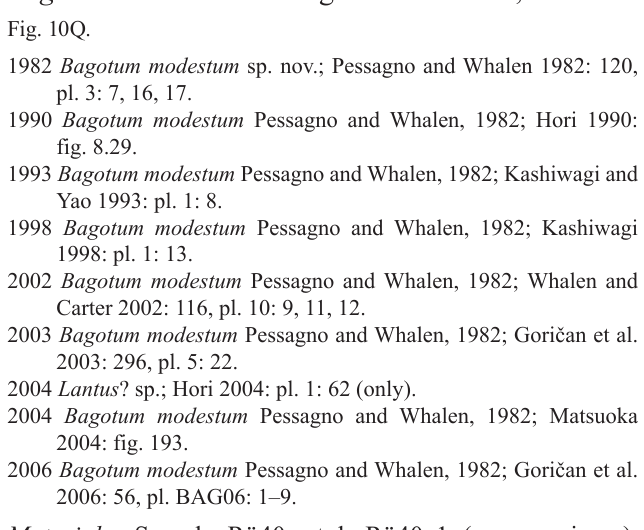
Fig. 10. Radiolarians from Mount Rettenstein, Austria, Pliensbachian, Early Jurassic. A – D . Droltus eurasiaticus Kozur and Mostler, 1990. A . Sample Rö416. B – D . Sample Rö37. E , F . Droltus laseekensis Pessagno and Whalen, 1982, sample Rö416. G , H . Droltus sanignacioensis Whalen and